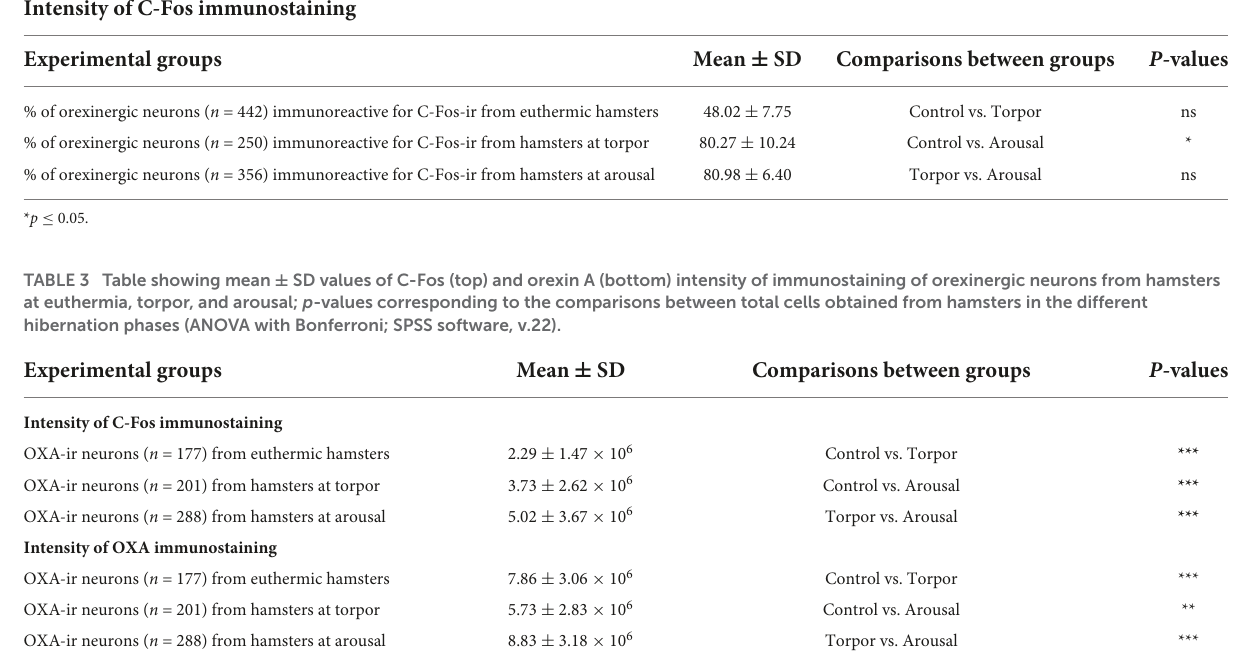
TABLE 2 Table showing mean ± SD values of the percentage of orexinergic neurons positive for C-Fos from hamsters at euthermia, torpor, and arousal; p -values corresponding to the comparisons between total cells obtained from hamsters in the different hibernation phases (Kruskal-Wallis with Dunn; SPSS software, v.22).